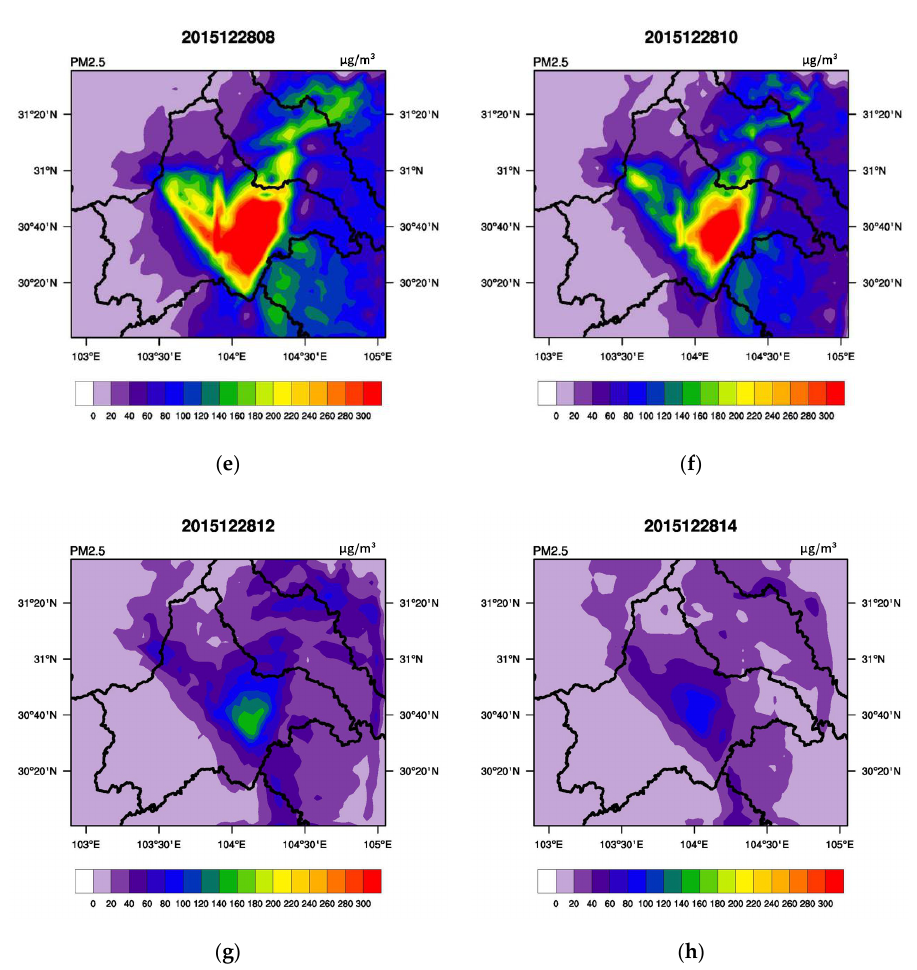
Figure 12. The simulated PM 2.5 concentrations using 2015 land-use data, ( a – h ): local time from 18:00 on 27 December 2015, to 14:00 on 28 December 2015.